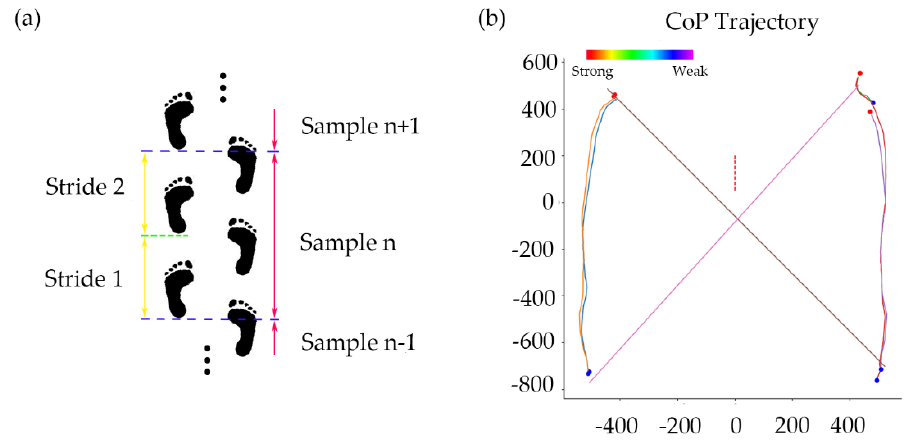
Figure 3. ( a ) Schematic diagram of the period division. ( b ) Center of Pressure (CoP) path for each partition period. The color represents the pressure.